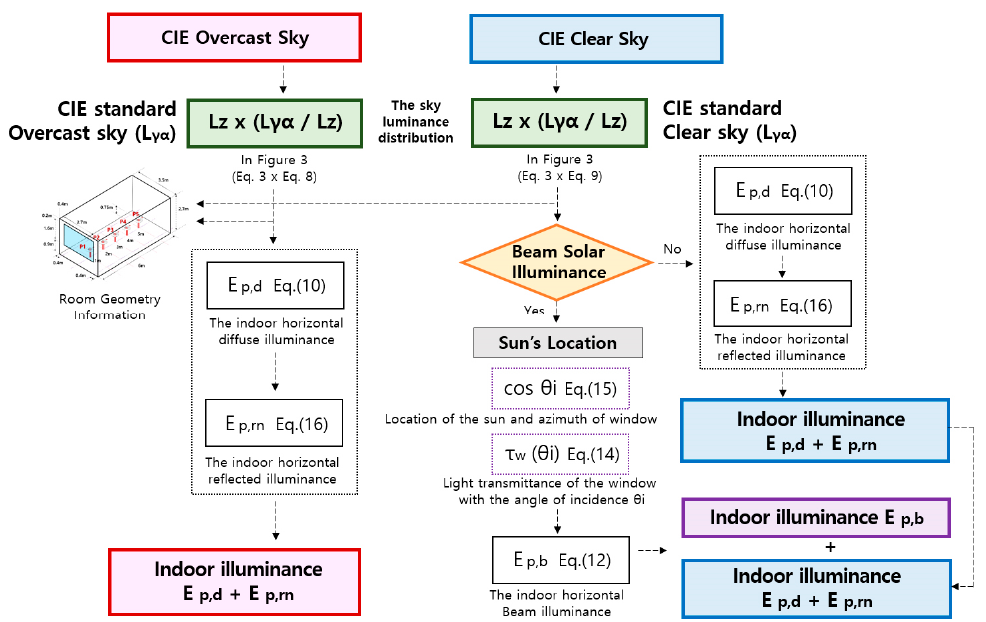
Figure 5. Diagram used in calculating the indoor illuminance in CIE clear and overcast sky. Table 2. Comparison of DeLight algorithm and suggested daylight algorithm.